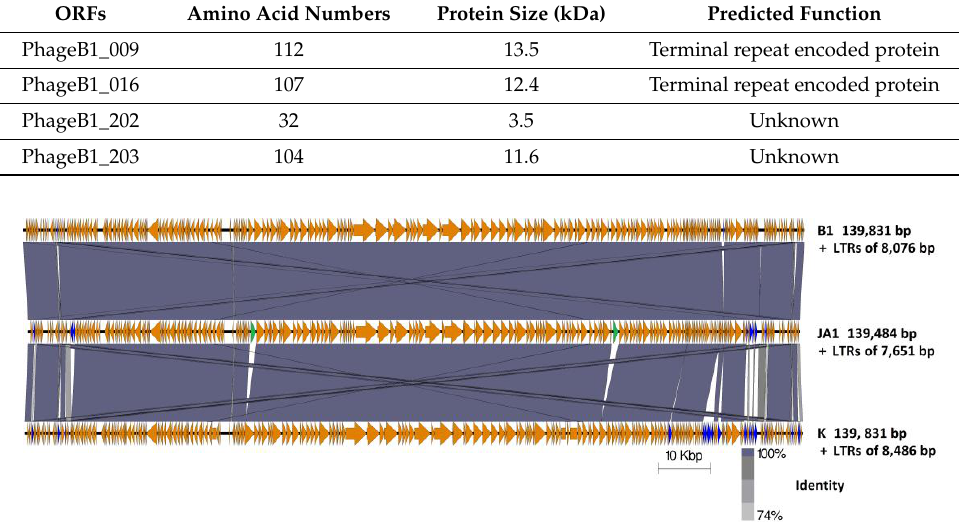
Figure 2. Genome comparison of phages B1, JA1, and K (including their long terminal repeats) using currently available annotations employing BLASTN and visualized with Easyfig. Regions of sequence similarity are connected by the shaded area, using a grey scale; genome maps consisting of orange arrows indicating the location of ORFs along the phage genomes, with unshared ORFs highlighted in blue with those indicating unshared homing endonuclease highlighted in green. Table 5. List of missing ORFs and their predicted putative functions absent in both phages B1 and JA1 but present in phage K.